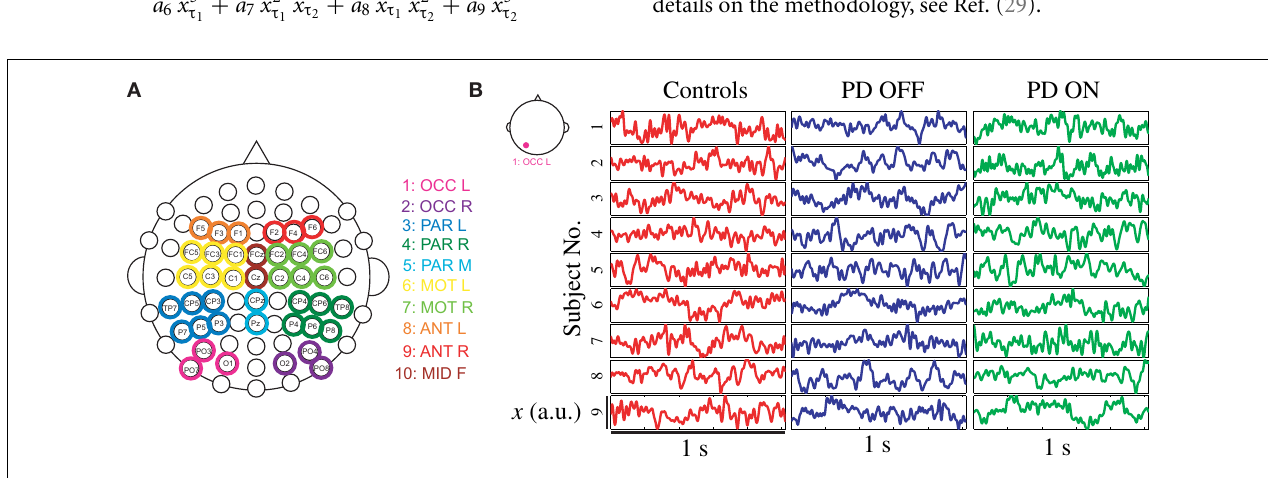
FIGURE 1 | (A) Overview of EEG data clusters used in analysis, and (B) randomly selected EEG time series from each participant sampled at 512Hz from left occipital cluster during 1-s baseline trial. Note: OCC, occipital; PAR, parietal; MOT, motor; ANT, anterior; L, left; R, right; F,